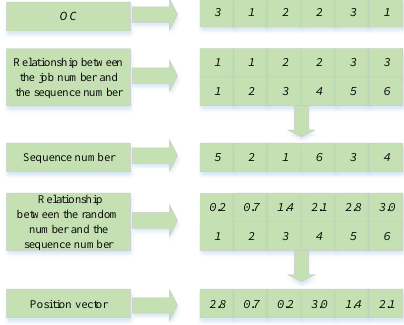
Figure 2. Individual position vector.